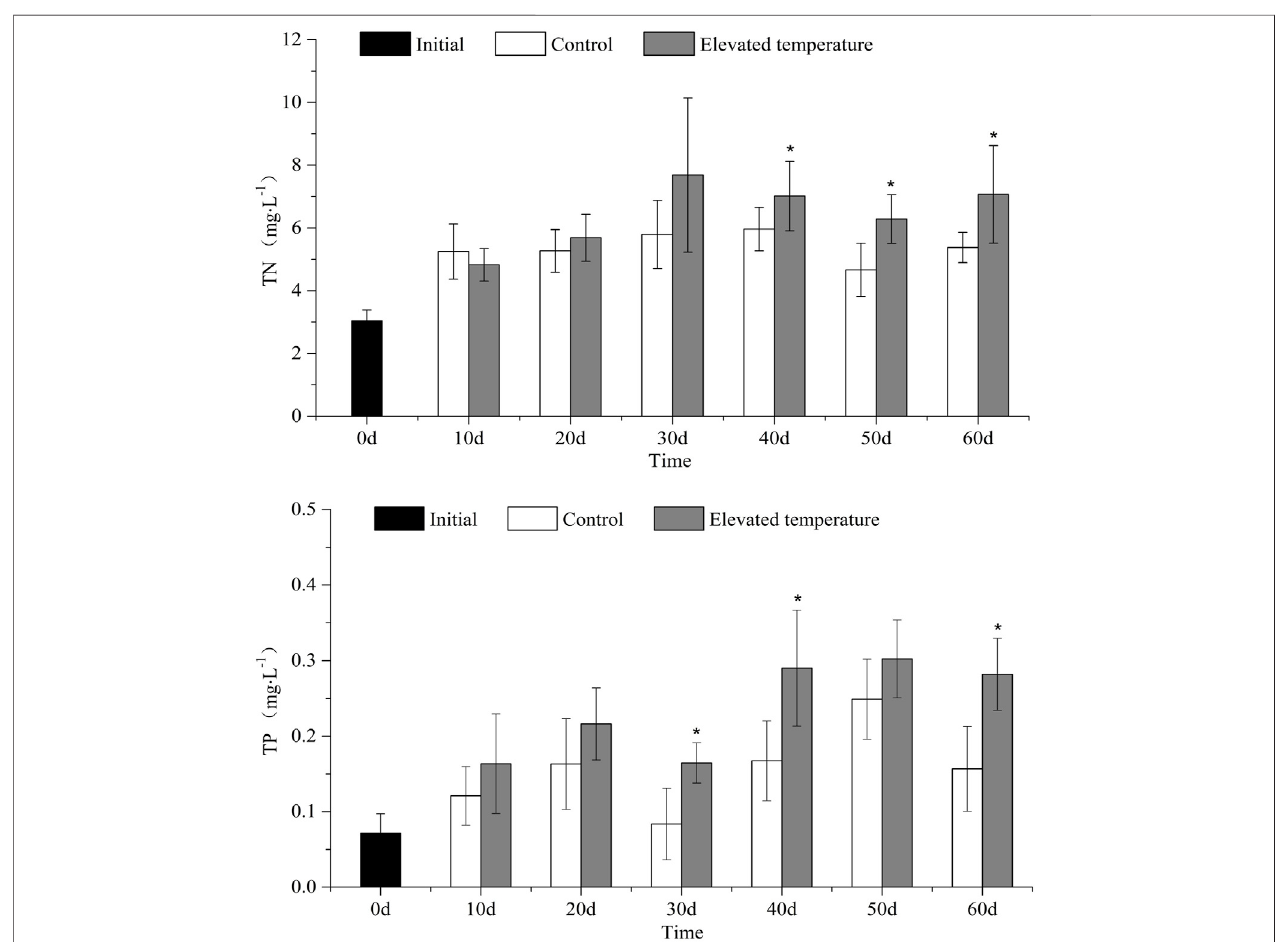
FIGURE 1 | TN (mean ± SD) and TP (mean ± SD) in different treatments over time. Asterisk indicates signi fi cant ( p < 0.05) differences between treatments.